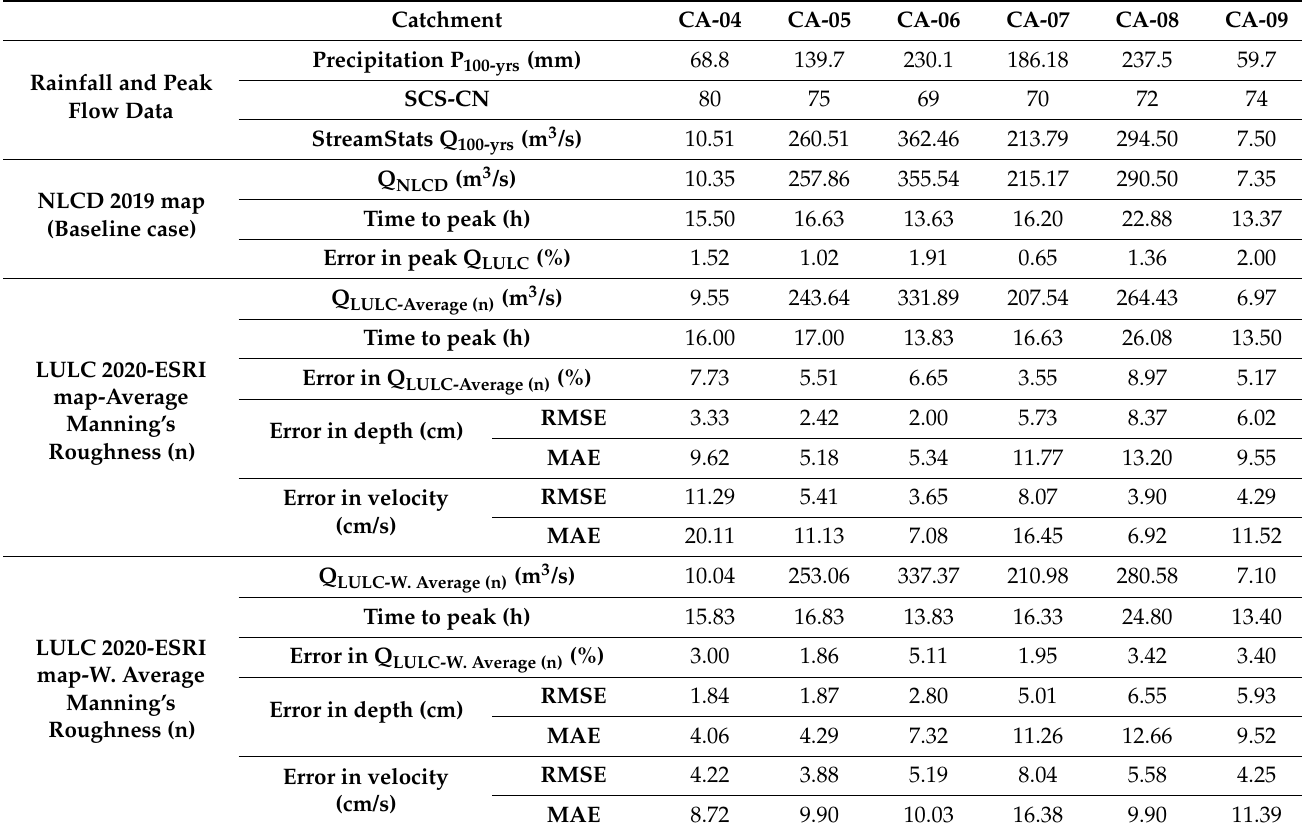
Table 9. Validation data and analysis results for a 100-year return